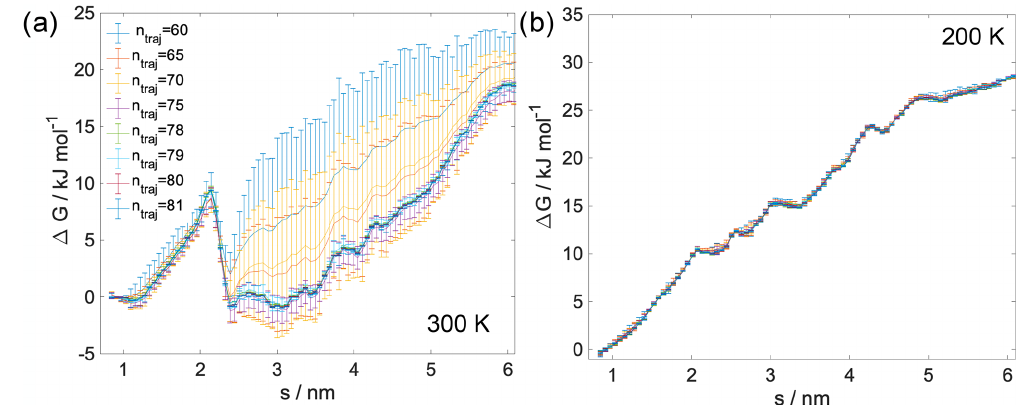
Figure C1. Mean free-energy profiles with varying sample sizes at (a) 300 and (b) 200K. Error bars represent 1 standard deviation.